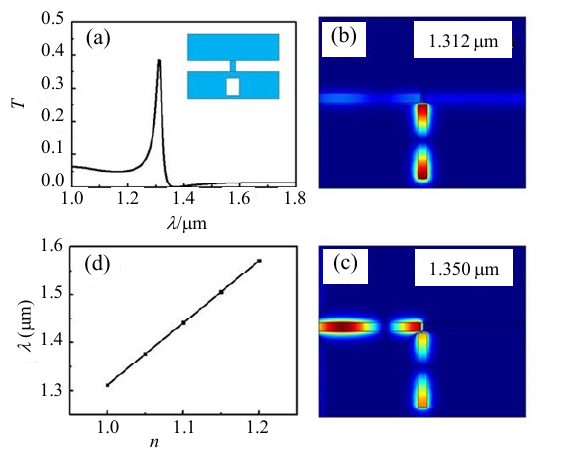
Fig. 4 Simulation results, where only rectangular cavity B is considered: (a) transmission spectra of the side-coupled resonator systems, (b) and (c) the field distributions of |H z | at the transmitted peak (1312 nm) and dip (1350 nm), respectively, and (d) the wavelength of the Fano resonance peak as a function of the refractive